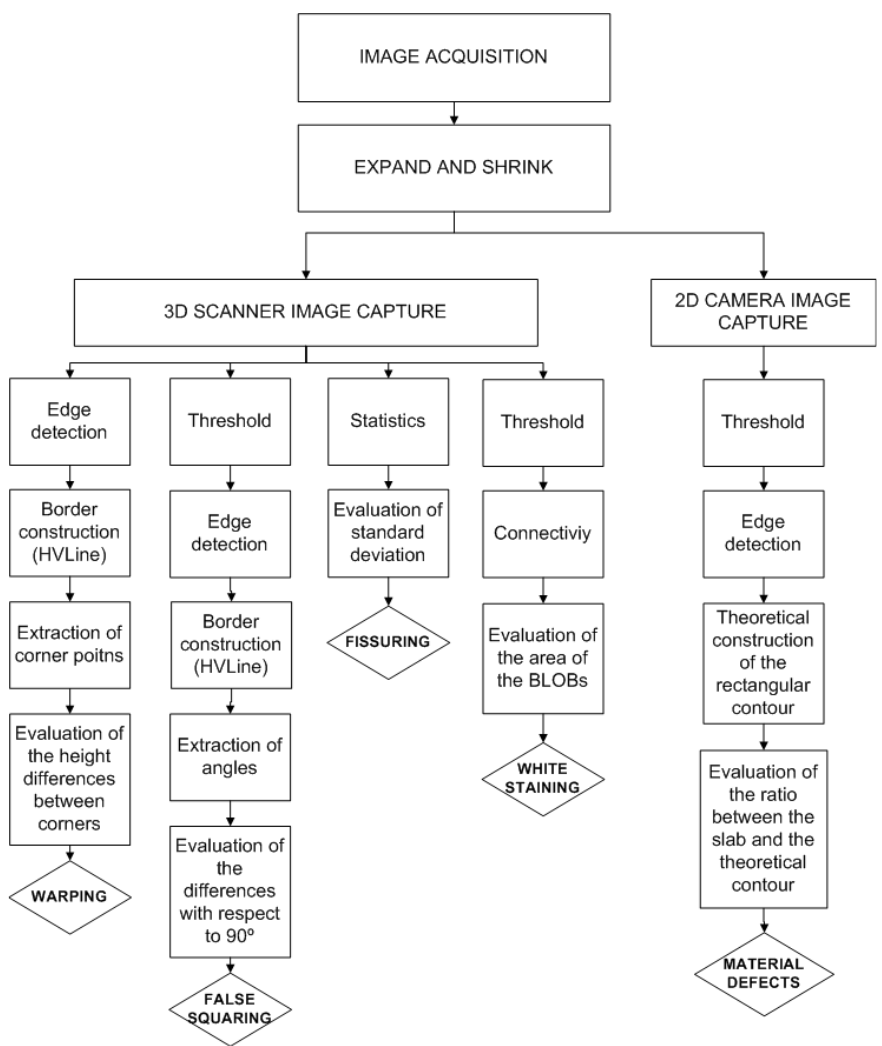
Figure 9. Flow diagram of the algorithms used to detect each kind of